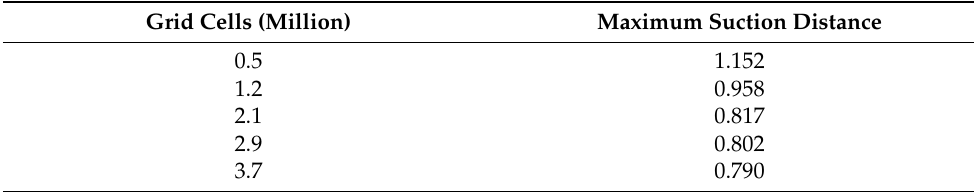
Figure 3. Physical model schematic. ( a ) Numerical model sketch; ( b ) Grid graphics; and ( c ) Microchannel local magnification grid pattern. Table 1. Grid independence checking results.